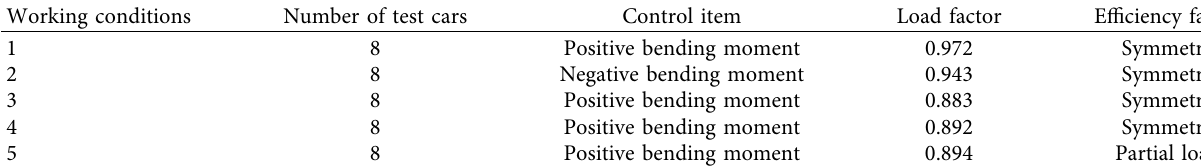
Table 2: Static load conditions and efficiency coefficients.